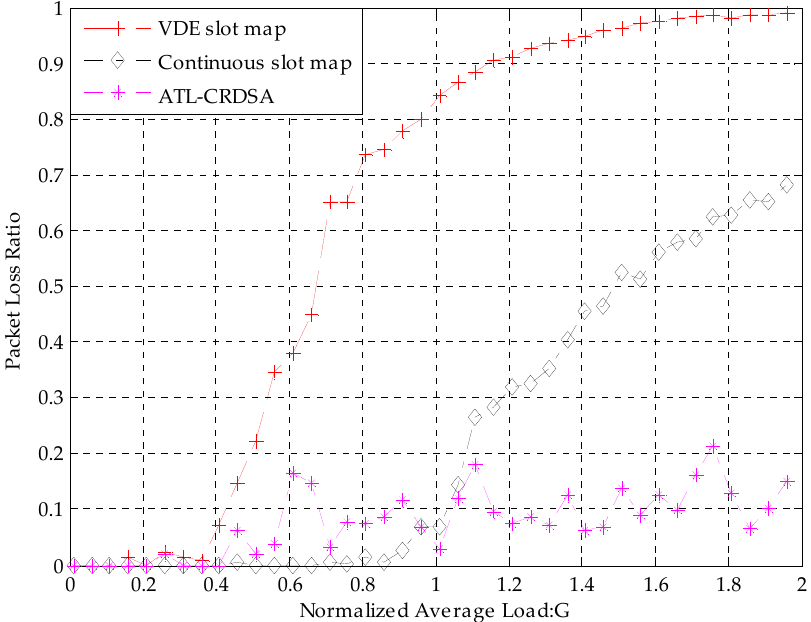
Figure 8. Packet loss ratio of ATL-CRDSA in VDE slot map and CRDSA in continuous and VDE slot maps.